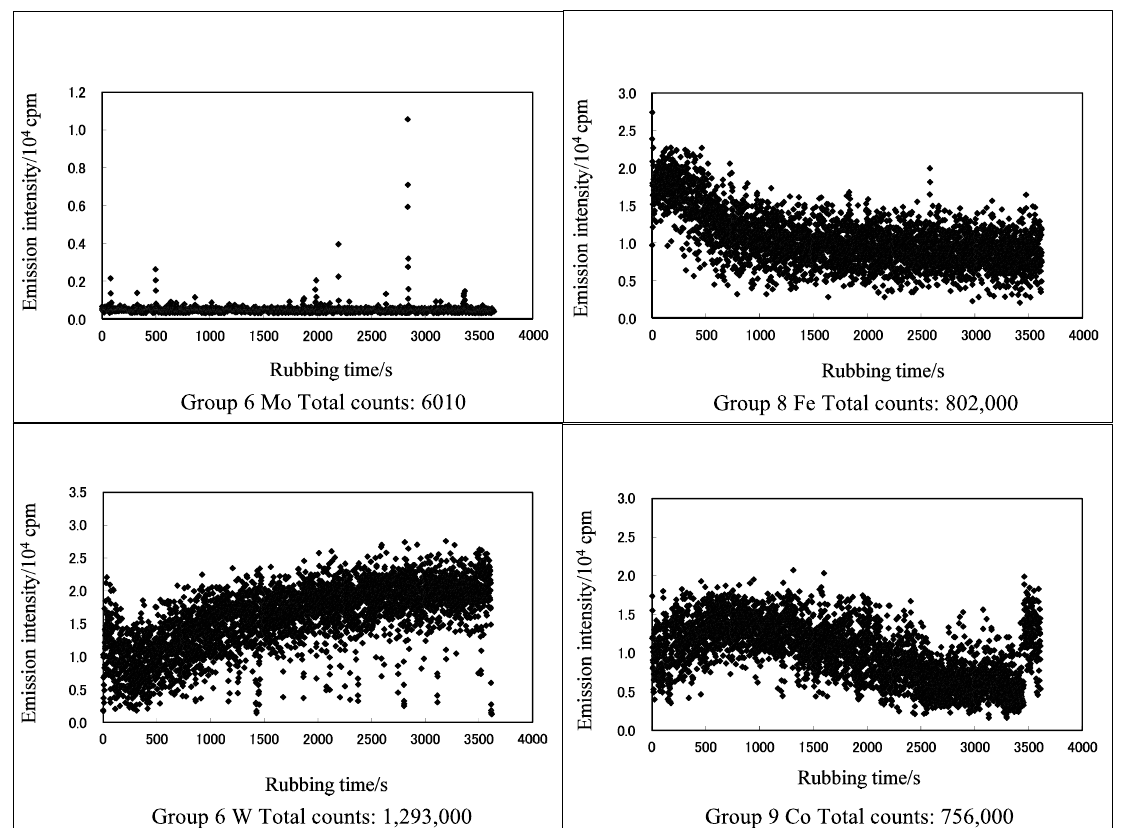
Figure 2. The change in intensity (cpm: counts/min) of TriboEE with rubbing time for groups 6 (Mo and W), 8 (Fe), and 9 (Co), giving the median value of TriboEE intensity.